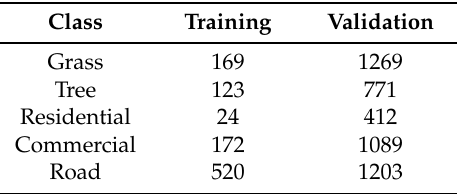
Table 3. Detail of the number of training and validation samples used for each ground cover